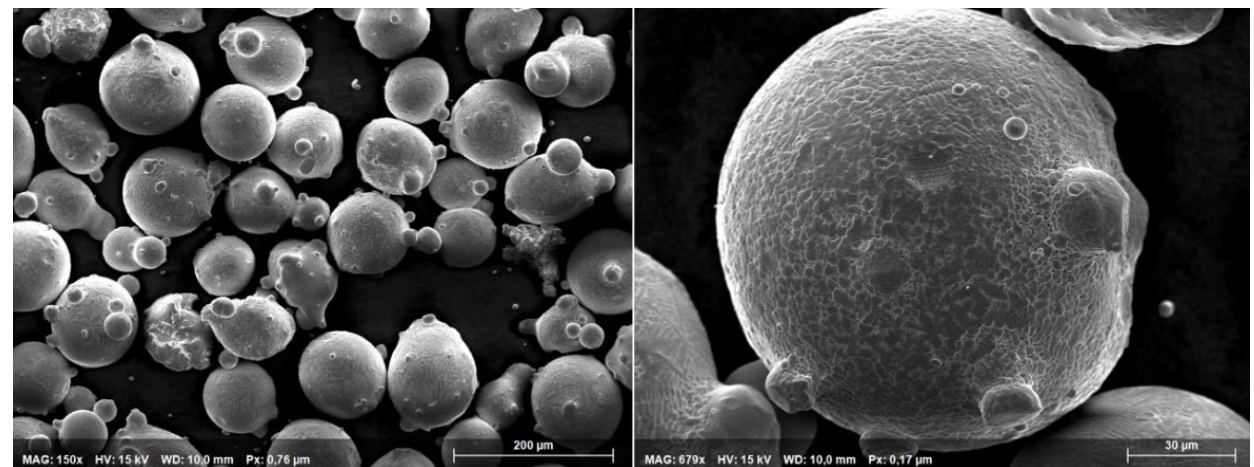
Figure 4. SEM imaging of powder particles MetcoClad21.